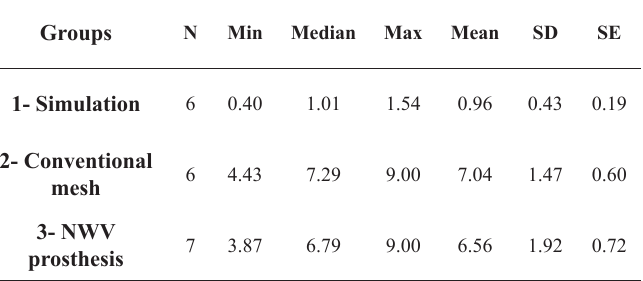
TABLE 3 - Statistical data of area of adhesion (cm 2 ).